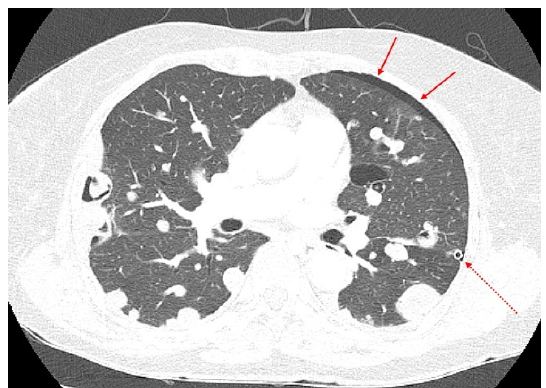
Figure 1. A chest computed tomography (CT) features of the lung masses. A chest CT (April 2017) showed pneumothorax in the left lung and multiple masses in both lungs. The amount of pneumothorax was small (solid arrows) because CT was performed after the chest tube (dotted arrows) was inserted and stabilized.